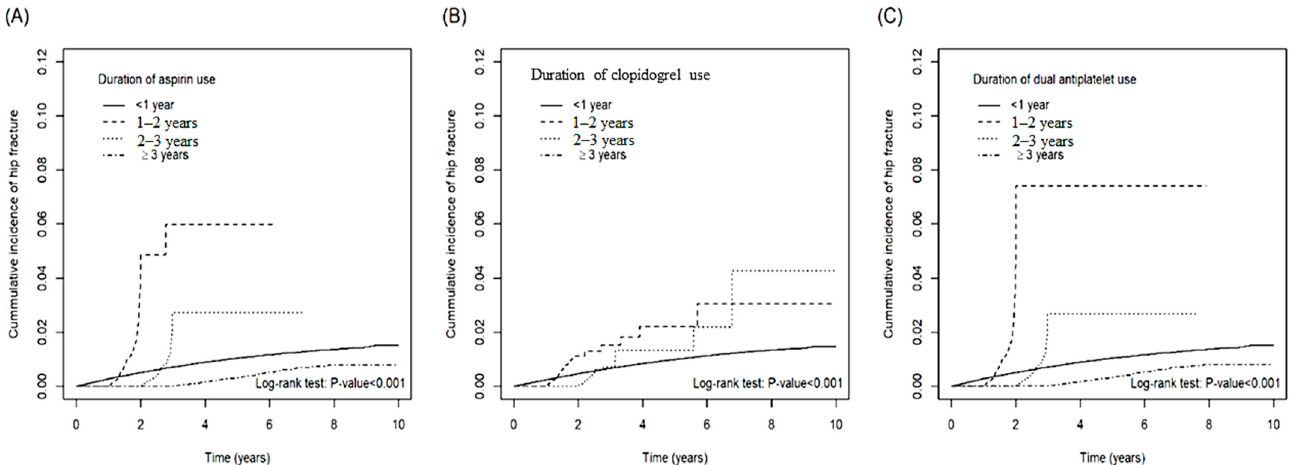
Figure 2. The cumulative incidence of hip fracture among patients with different duration (years) of aspirin ( A ), clopidogrel ( B ), and dual anti-platelet agents ( C ). Table 3 shows the risk of hip fracture stratified by sex, age, CCIs, aDCSI, and the diagnosis of osteoporosis. In general, the impact of antiplatelet agents on hip fracture could not be demonstrated without the stratification of dosage and duration. However, the stratification based on age, CCIs, aDCSI, and the diagnosis of osteoporosis showed that the female T2DM patients undergoing aspirin monotherapy seems to have lower risk of hip fracture than the female T2DM patients without any anti-platelet therapy. Table 3. Risk of hip fracture in different subgroups.